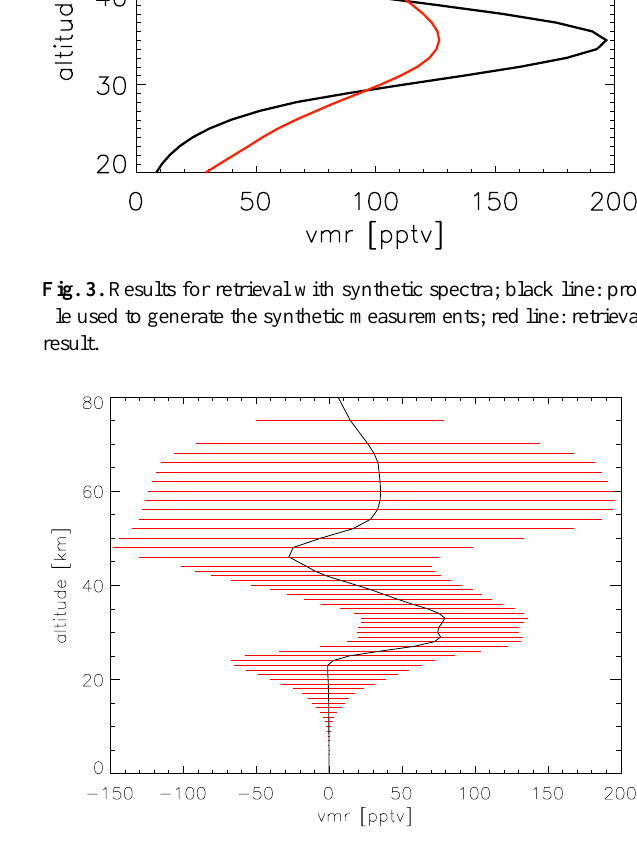
Fig. 4. Hydrogen peroxide retrieval result (solid line) (orbit 7791, 27 August 2003, tropics). Error bars represent propagated measure- ment